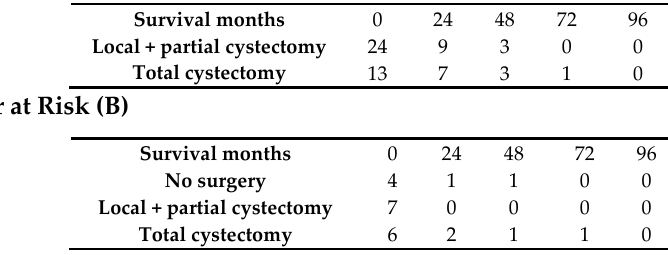
Figure 2. Kaplan–Meier curves and risk tables demonstrating survival for ( A ) muscle invasive cases of CCA defined by AJCC 6th stage II and III and ( B ) metastatic CCA cases defined by AJCC 6th stage IV.